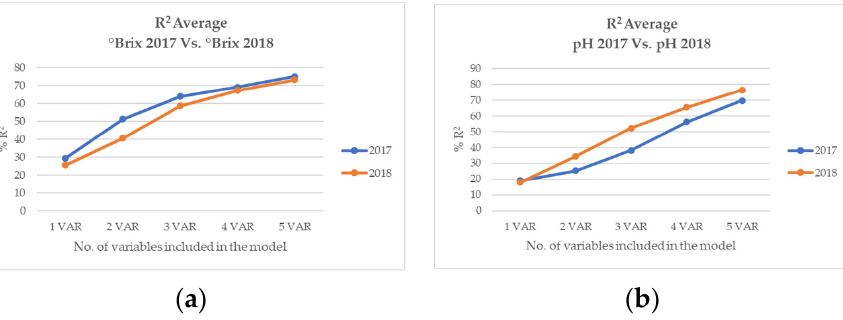
Figure 8. Average of R 2 coefficients in 2017 and 2018 seasons based on the number of variables used in the model. (a) Brix, and (b) pH.